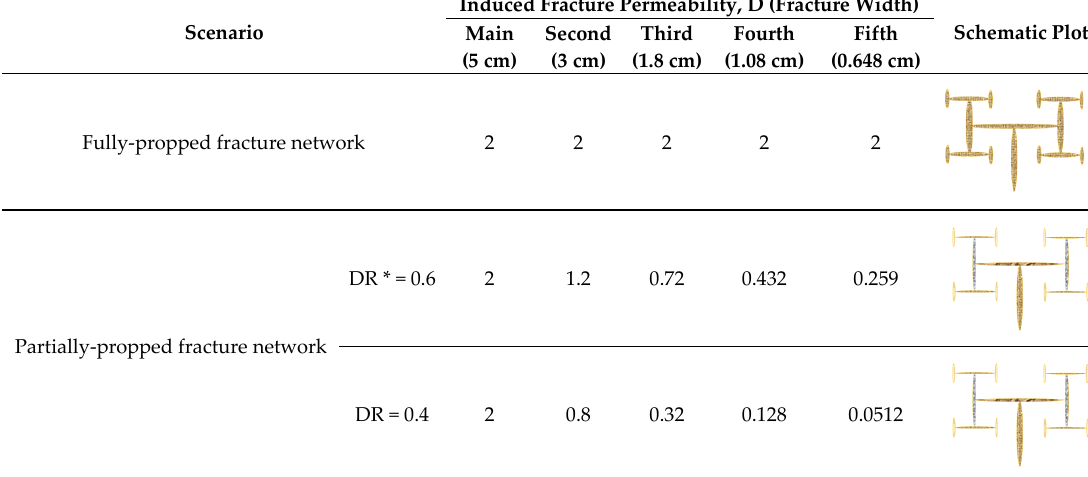
Table 2. Different propped fracture network scenario and